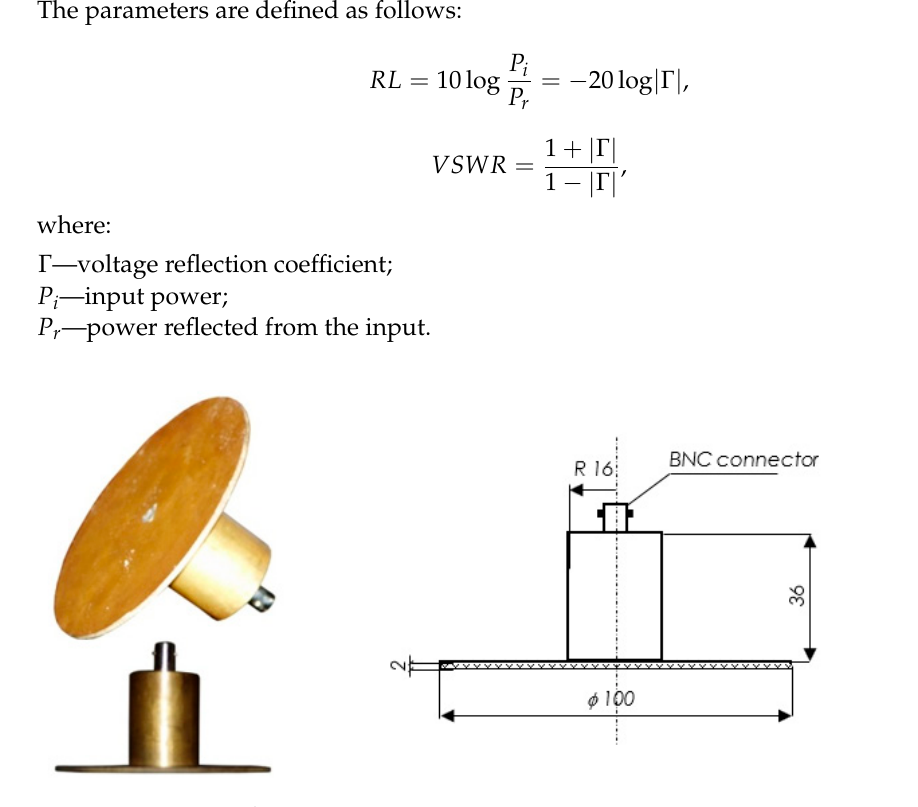
Figure 1. Capacitive disc sensor. The parameters listed above are determined automatically using a specialized device— an antenna analyzer. An antenna and spectrum analyzer KC901S+ by Measall Technology was used to determine the frequency response in the high and ultra-high frequency range. The measurements were each time preceded by a standard calibration procedure. As a result, the characteristics in Figure 2 were obtained.